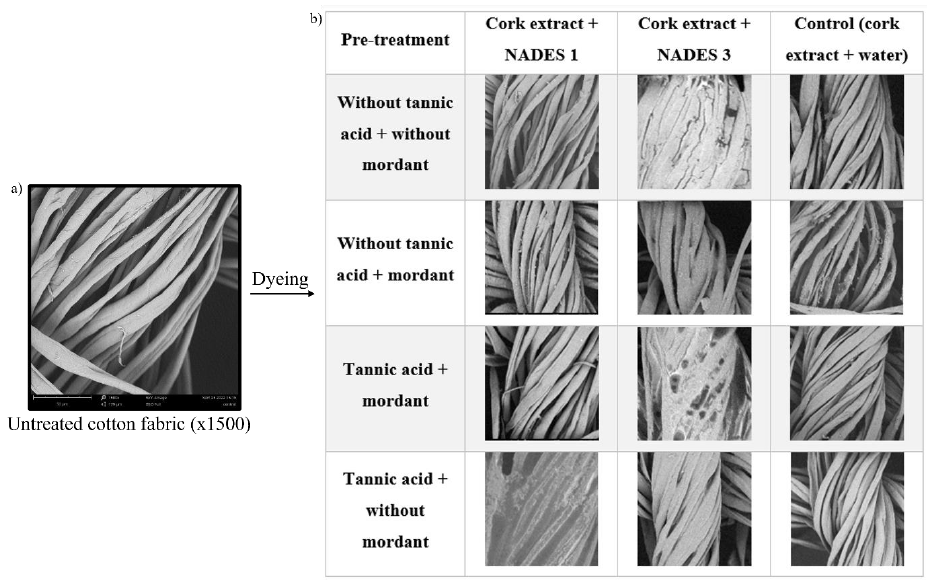
Figure 9. ( a ) SEM of untreated cotton fabrics and ( b ) SEM of pre-treated fabrics with tannic acid and/or aluminum (mordant) and dyed with cork extracts E1 and E3 and control (extract obtained by extraction with water) (Images ×1500).